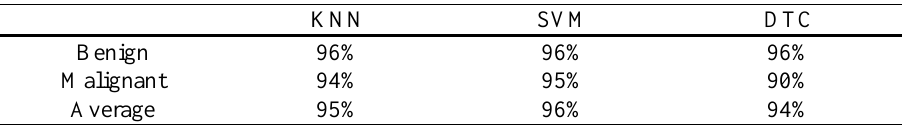
Table 4. Recall values of